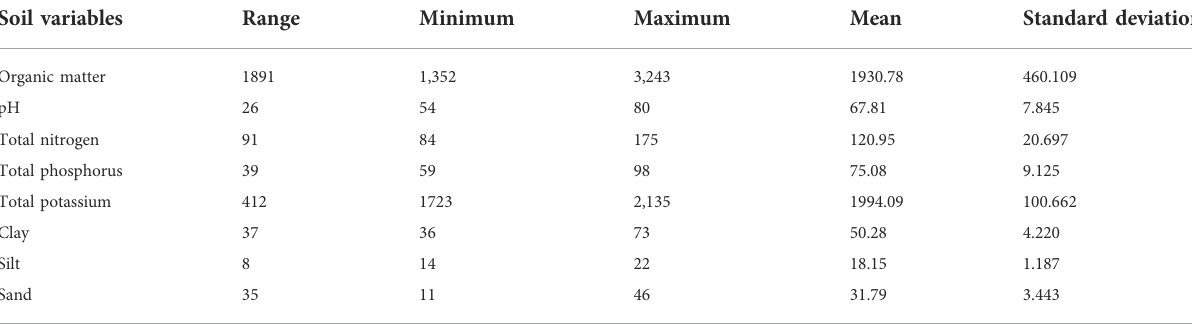
TABLE 7 Descriptive statistics of soil environmental variables of Citrus sampling points in plain and hilly